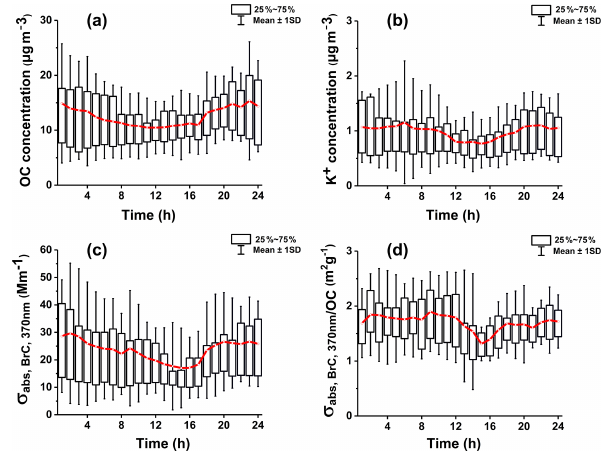
Figure 7. Box–whisker plots of diurnal trends in the OC concentra- tion (a) , water-soluble K + concentration (b) , σ abs , BrC , 370nm (c) , and σ abs , BrC , 370nm /OC (d) . The red traces represent the variation in the average value. The upper and lower boundaries of the box represent the 75th and 25th percentiles, respectively; the whiskers above and below each box represent an error of 1 standard devia-